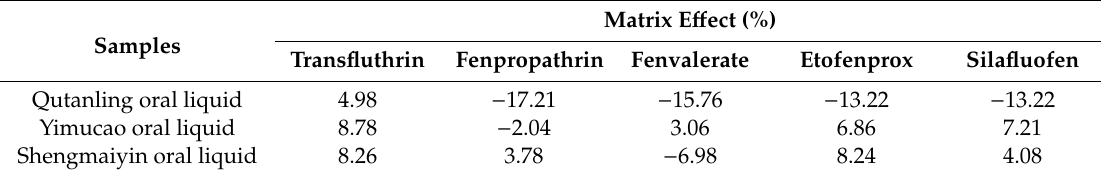
Table 3. Matrix e ff ect of five pyrethroids in di ff erent oral liquid Table 3. Matrix effect of five pyrethroids in different oral liquid samples.